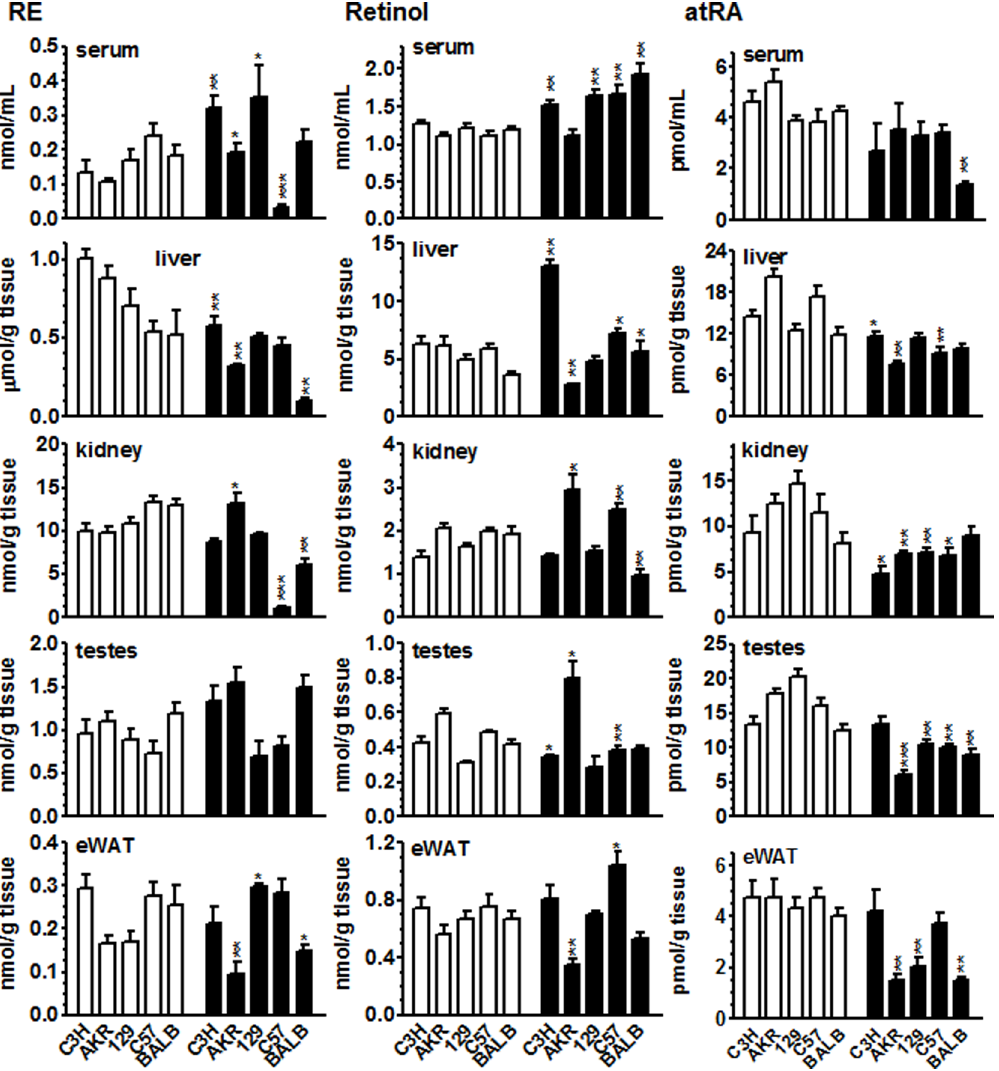
Figure 1. Retinoids in serum and tissues of five mouse strains. Retinyl esters (RE), retinol and all- trans -retinoic acid (atRA) in serum and tissues. Mice were fed a VAS after weaning from dams fed a chow diet (generation 1). Generation 1 mice were maintained and bred on the VAS, continuing into the third generation. Retinoids were quantified in male mice after week 9 of the first generation (open bars), or week 10 of the third generation (filled bars). Tissues and serum of 3 to 10 mice were assayed for each strain and generation: eWAT, epididymal white adipose tissue. Data are means 6 SE: * P , 0.05; ** P , 0.005, *** P , 0.001 relative to first generation values.